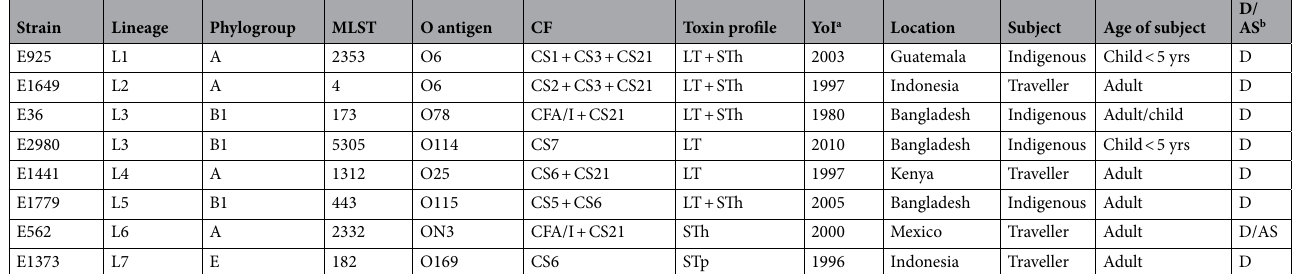
Table 1. Characteristics of the reference ETEC strains. a YoI: Year of isolation. b D/AS: Diarrhoea or